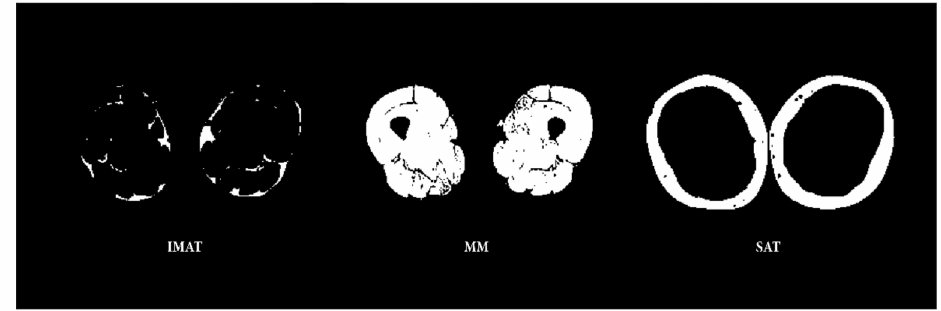
Figure 2. The segmentation results for IMAT, cross-sectional MA, and SAT of the